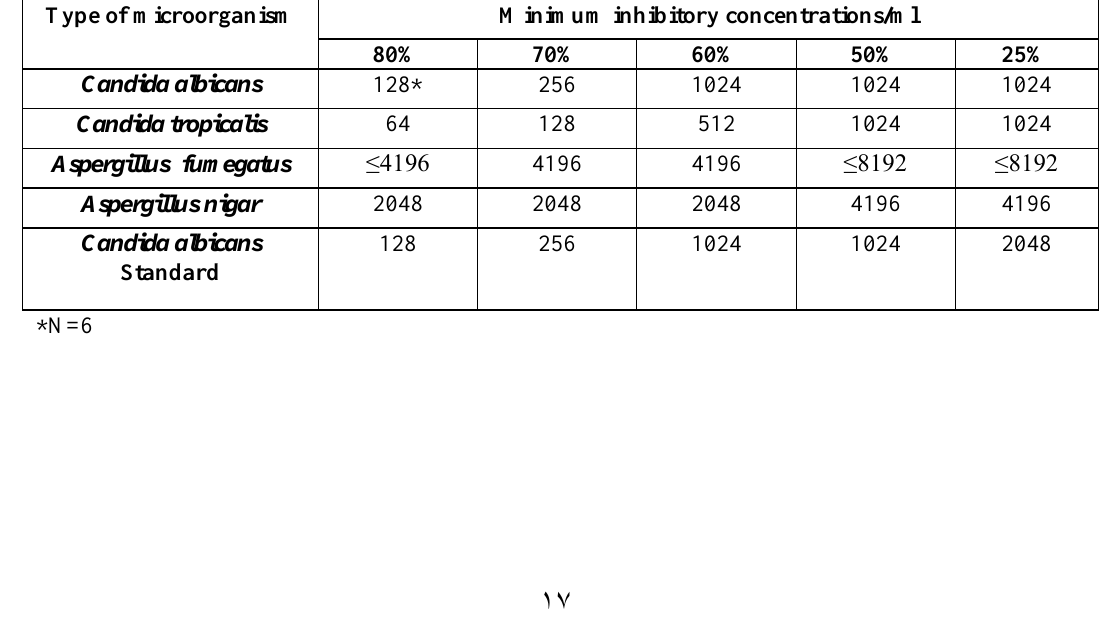
Table (4)- Minimum Inhibitory Concentrations µg/ml of Punica granatum Peels Alcoholic Extract of Different Concentrations Type of